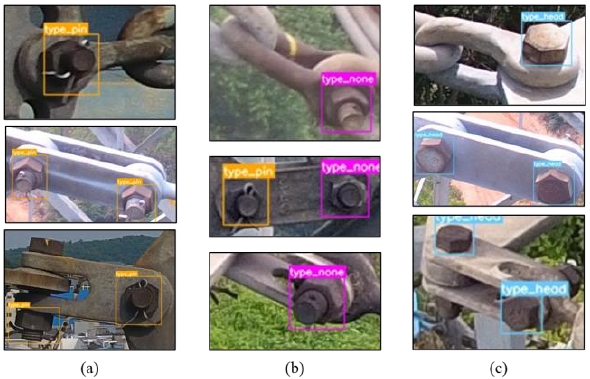
Figure 4 . Three classes of bolt-pin assemblies, the orange boxes in column (a) are normal bolts with pins, the magenta boxes in column (b) show bolts with pins missing, and the blue boxes in column (c) contain bolt heads.